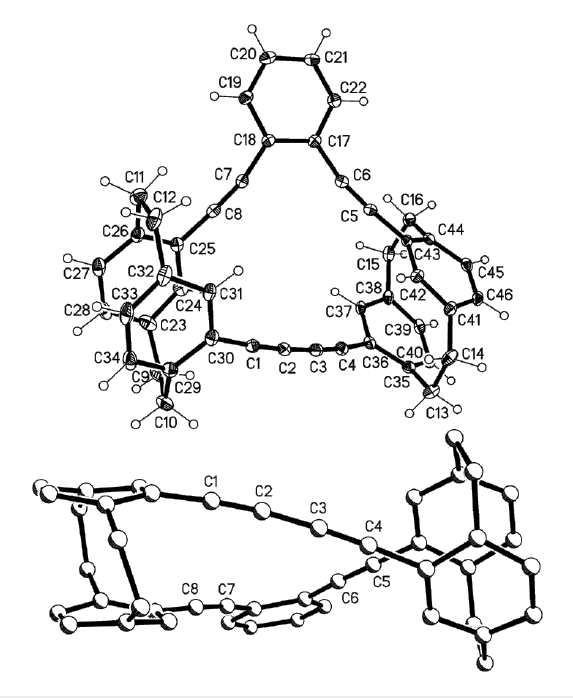
Figure 4: Above: One of the three independent molecules of com- pound 20 in the crystal; ellipsoids represent 30% probability levels. Solvent is omitted for clarity. Below: Alternative view direction (arbi- trary radii, without H atoms) of the same molecule, showing the “crossed” geometry via the additional bridges.